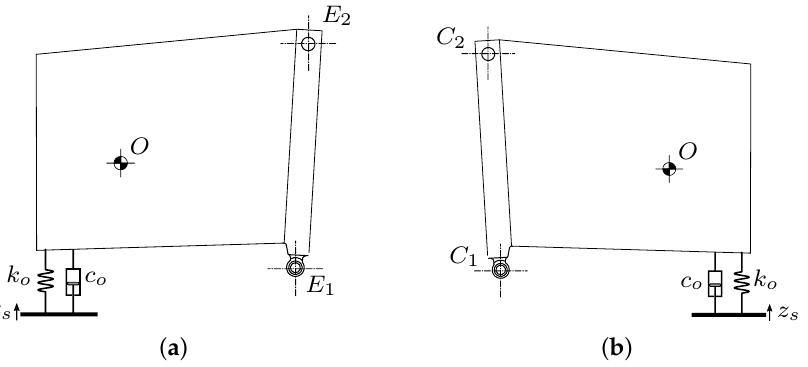
Figure 4. Lumped parameter models of mounted or semi-mounted machines: ( a ) rear machine; ( b ) front